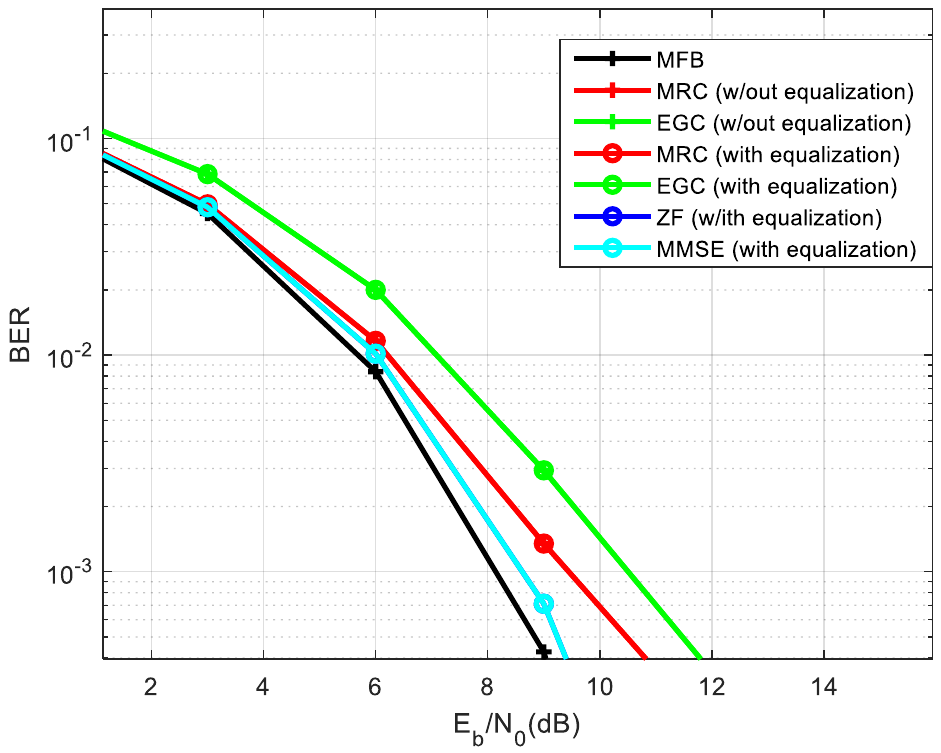
Figure 5. Results for 4X225 LIS System, with 5 users, without LDPC codes, with and without